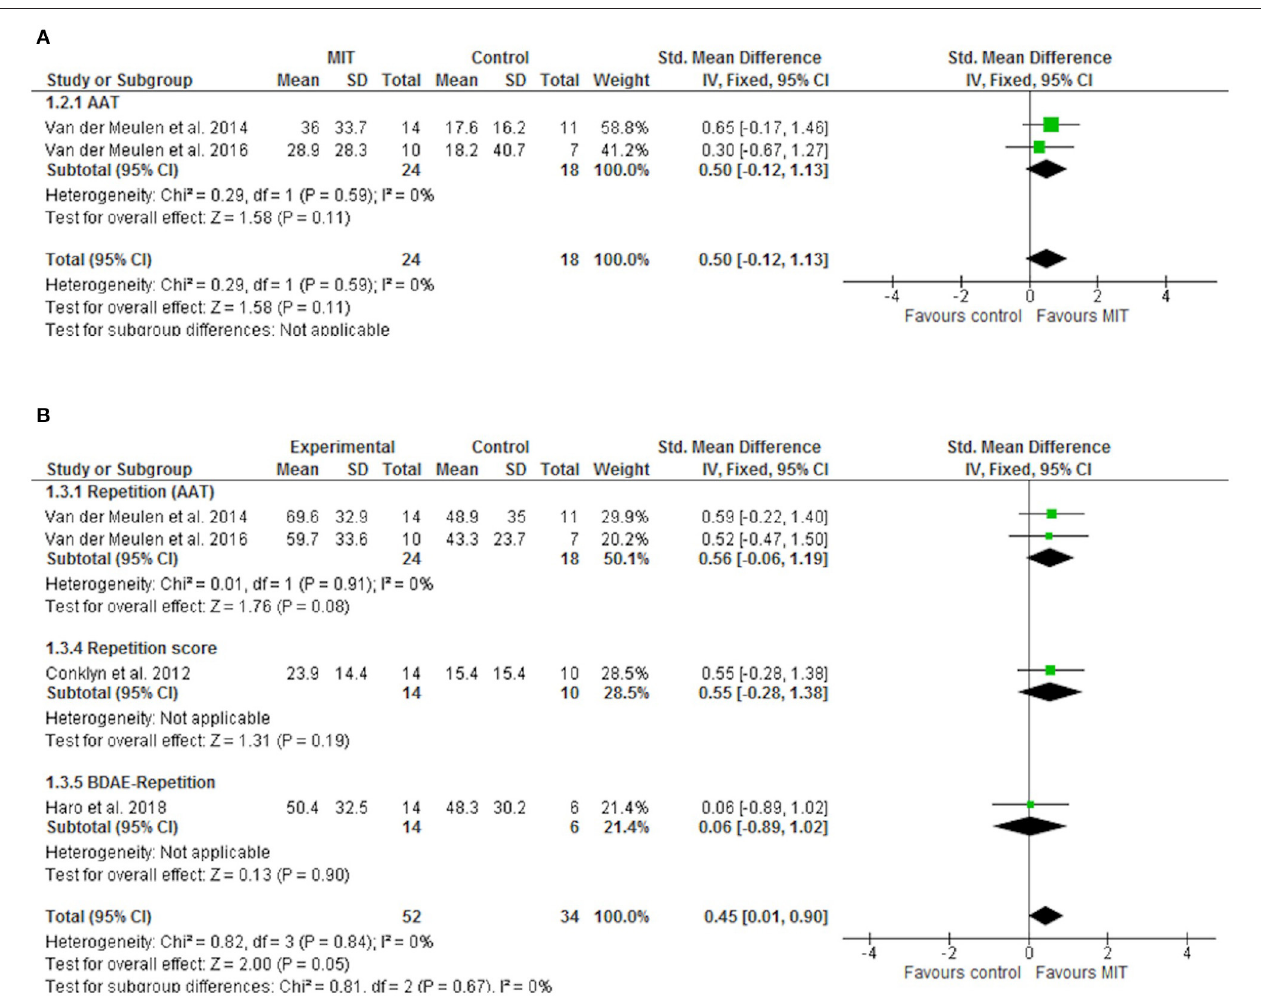
FIGURE 3 | Forest plot of the effect of MIT on expressive language. (A) Naming; (B) Repetition.